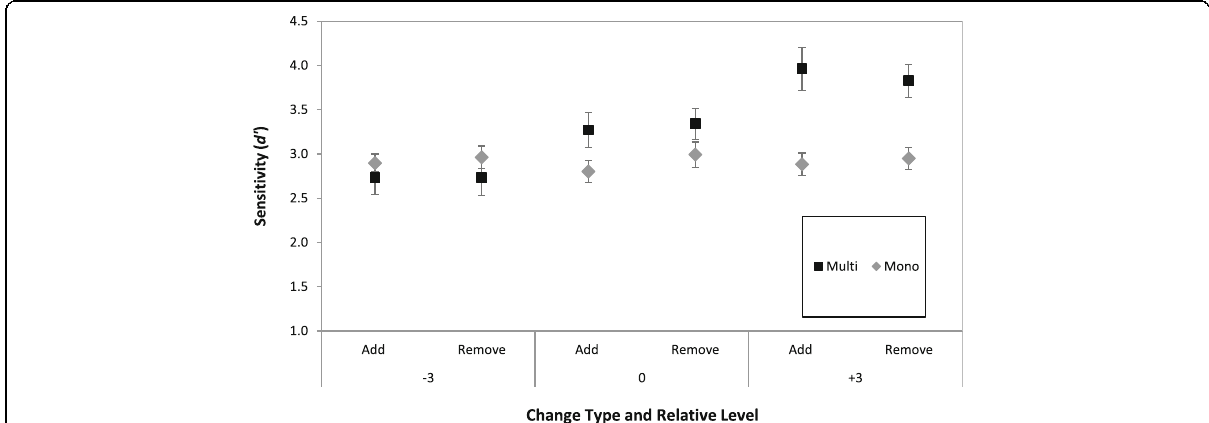
Fig. 3 Sensitivity in the change discrimination task as a function of spatial condition, change type, and relative target level, with SE bars